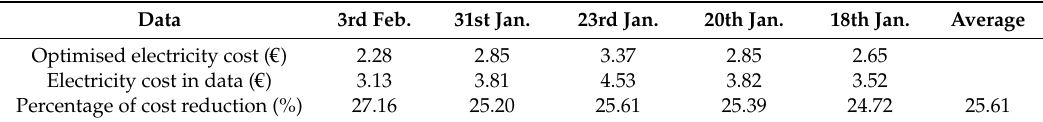
Table 2. Summary of results of the CSPSO for five cold winter days in 2019.